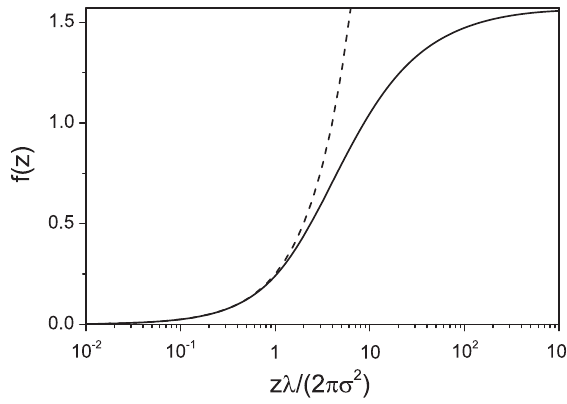
FIG. 2. Function f ð z Þ entering Eq. (3). The dashed line shows the asymptote (4) for small values of z , f ð ~ z Þ ¼ ~ z= 4